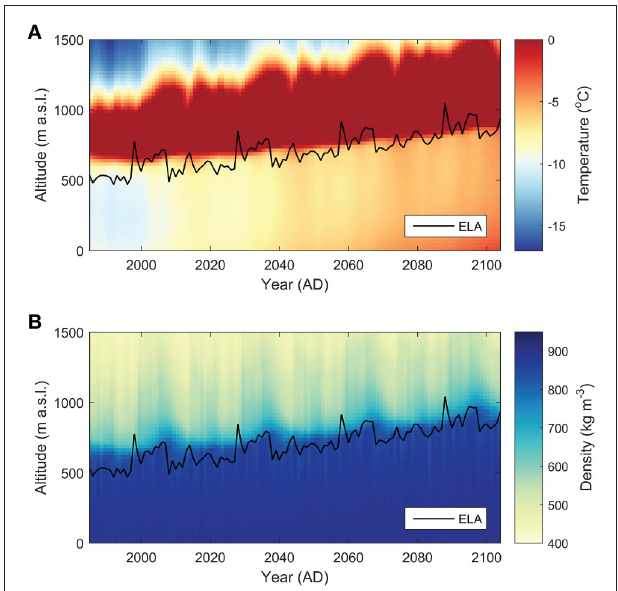
FIGURE 4 | Time-series of annual mean subsurface temperature at 15-m depth (A) and mean density in the first 10m (B) between 1984 and 2104, plotted as a function of elevation. The black line shows the evolution of the ELA. Years on the x-axis are defined between 1 September (preceding year) and 31